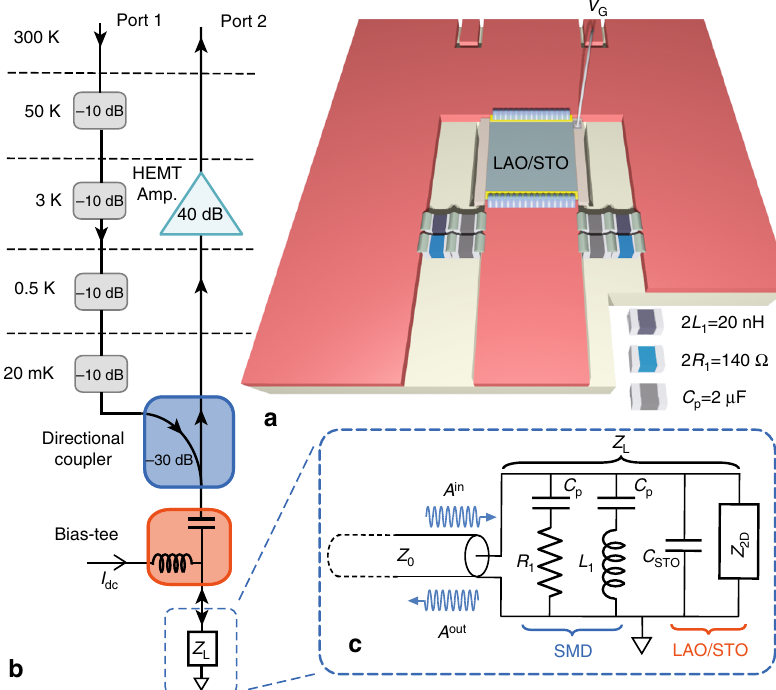
Fig. 1 The LaAlO 3 /SrTiO 3 sample and its microwave measurement setup. a LaAlO 3 /SrTiO 3 sample inserted between the central strip and the ground of a CPW transmission line, in parallel with SMD inductors L 1 and resistors R 1 . C p are protective capacitors that avoid dc current to fl ow through L 1 and R 1 without affecting ω Z fi ed readout line separated by a 0 . b Sample circuit of impedance L in its microwave measurement set-up that includes an attenuated input line and an ampli directional coupler. A bias-tee allows dc biasing of the sample. c Equivalent electrical circuit of the sample circuit including the SMDs and the LaAlO 3 /SrTiO 3 heterostructure modeled by an impedance Z 2D in parallel with a capacitor C STO . The re fl ection coef fi cient Γ ( ω ), taken at the discontinuity between the CPW line and the sample circuit, is de fi ned as the ratio of the complex amplitude of the re fl ected wave A out ( ω ) to that of the incident wave A in ( ω